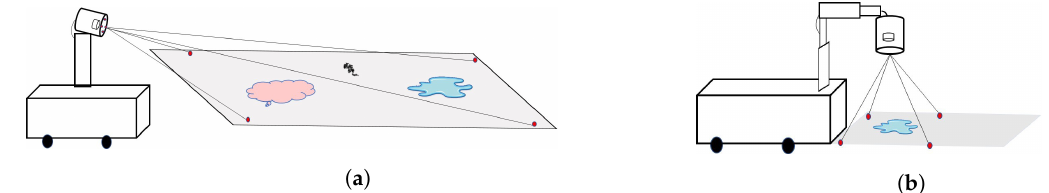
Figure 7. Camera arrangement for capturing floor images in the experiments. ( a ) Robot Perspective; ( b ) Top Perspective.